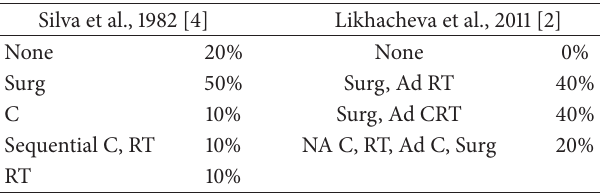
Table 3: Treatment of locoregional recurrence of neuroendocrine